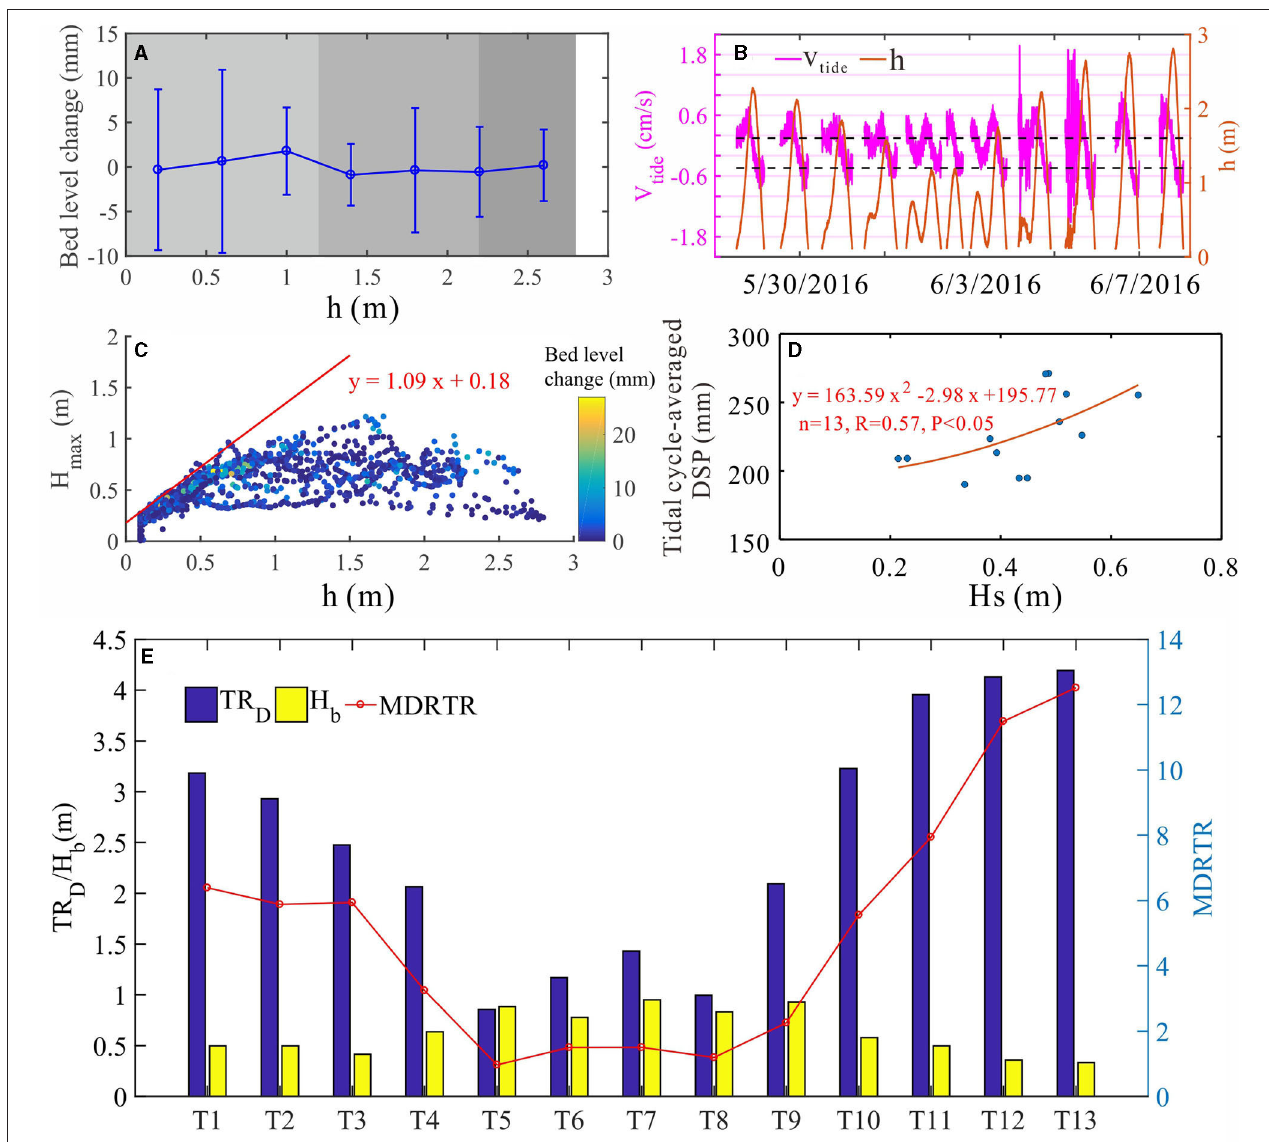
FIGURE 6 | (A) Bed level changes and the corresponding SD of the bed level for each 30min against mean h and the three boundaries of different areas at h = 1.2, 2.2, and 2.8m indicate the highest h of the neap tide, middle tide, and spring tide, respectively; (B) time series of averaged horizontal tidal translation rate ( V tide , magenta line) and h (red line). Two horizontal dashed lines indicate h = 1.2 and 1.6m. Note that V tide was abnormal at the start of the flood tide during June 4 (T10) and June 5 (T11) due to the high-frequency fluctuation of h; (C) maximum wave height ( H max ) and bed level changes of each 30min against water depth (h), the red line indicates the limitation of h on maximum wave heights ( H max ); (D) tidal cycle-averaged DSP against tidal cycle-averaged Hs over the observation; (E) daily tide range ( TR D , blue bar), breaker height ( H b , yellow bar), and mean daily relative tide range (MDRTR, red circle and red line) of each tidal